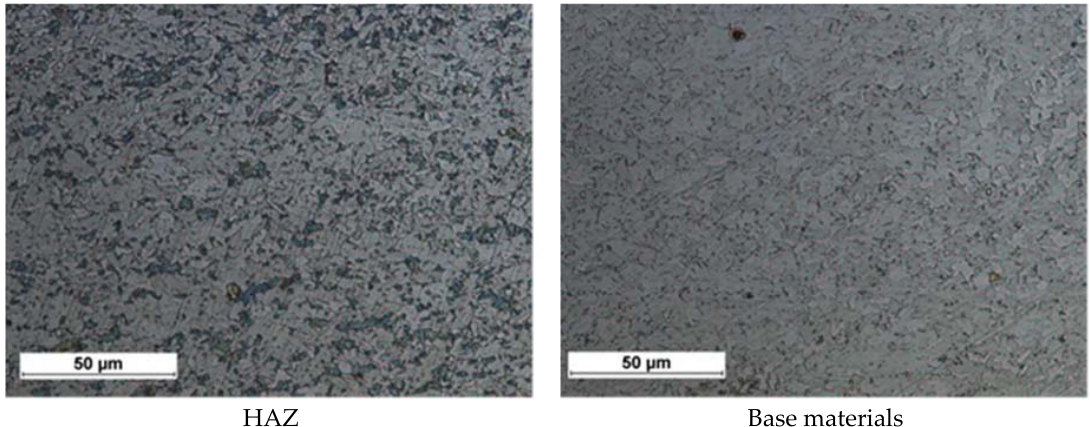
Figure 10. Example microstructure of the welded joint No. 4, right weld of joint.